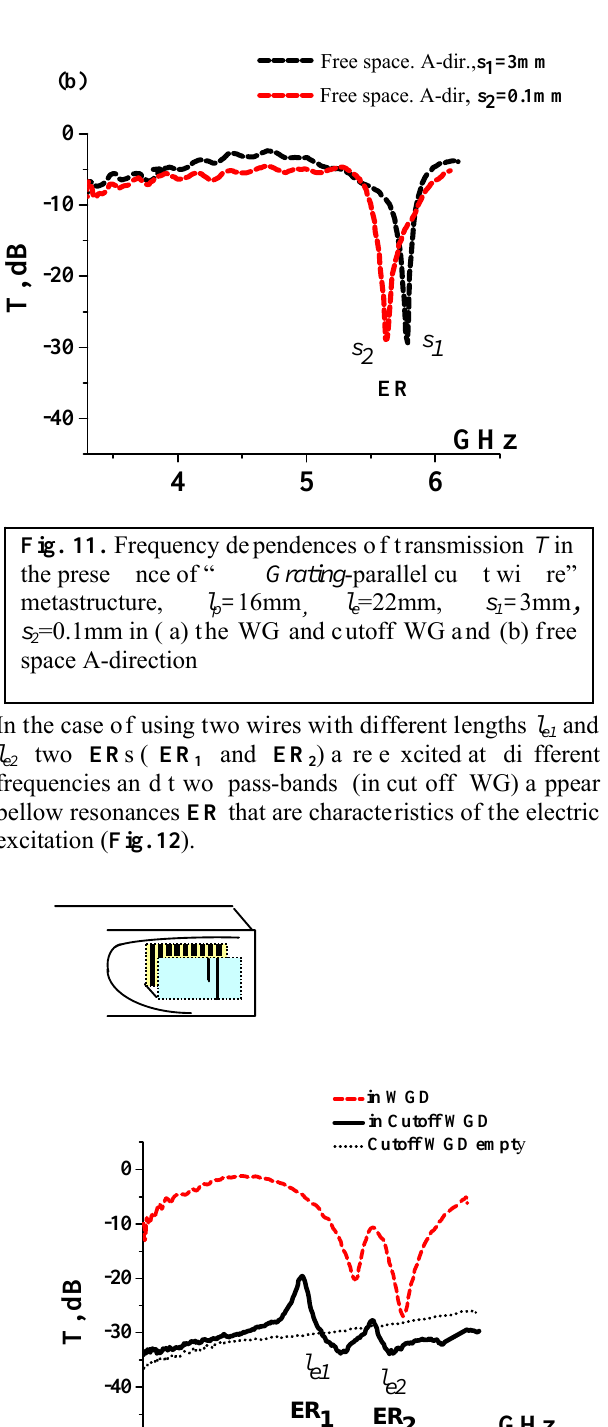
Fig . 15a,b. Fre quency de pendences o f transmission T in the prese nce of m etastructure “ Cut-wire pair- varactor loaded split longitudinal cut-wire l m ” ( l m = 32mm, l AB =22mm, s= 2.5mm) under different bias conditions in (a) WG and (b) cutoff WG,